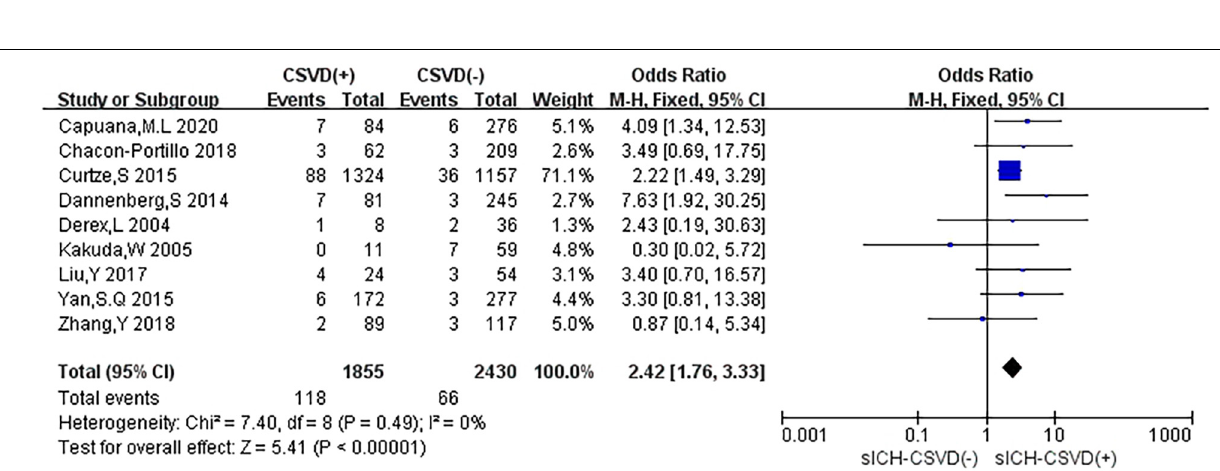
FIGURE 4 | Funnel plot and Egger’s test of studies evaluating the association between CSVD and HT.